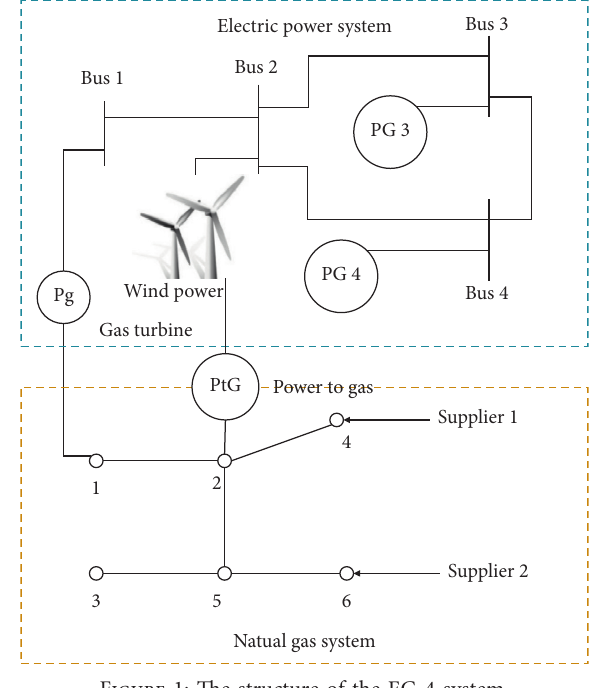
Figure 1: The structure of the EG-4 system.